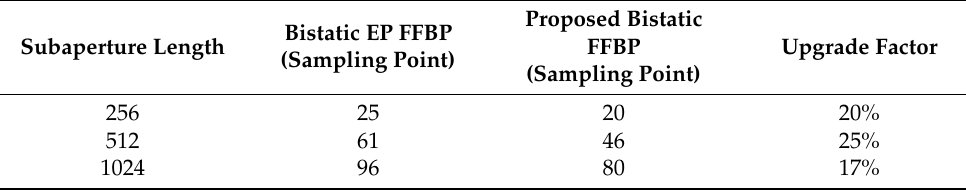
Table 1. Two-dimensional (2D) spectrum angular width of the single ideal point target with the different subaperture lengths n